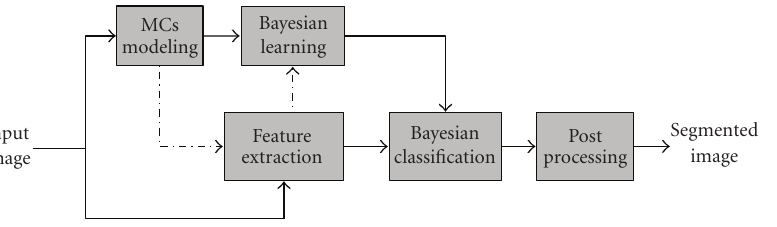
Figure 2: Segmentation using Bayesian learning.